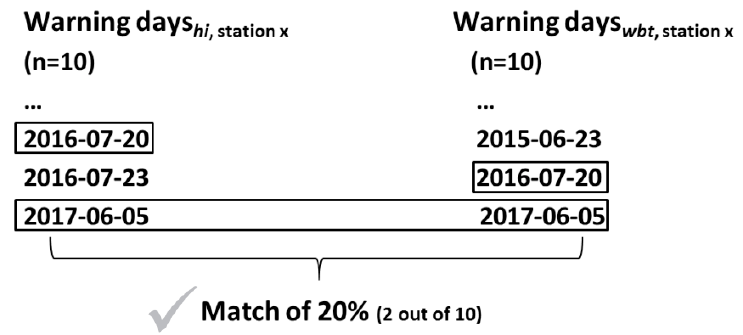
Figure 3. Exemplary matching of warning days ( n = 10) based on hi (left) and wbt (right) for a station x. The black boxes mark matching warnings. Two out of ten wbt -based warning days match the official hi -based warning days, resulting in an overall 20% match using wbt in station x.